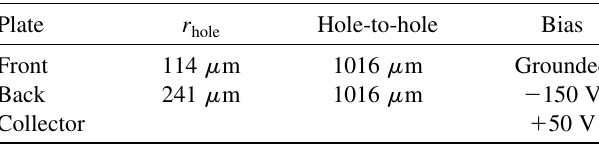
TABLE I. Pinhole Faraday cup specifications. Plate r